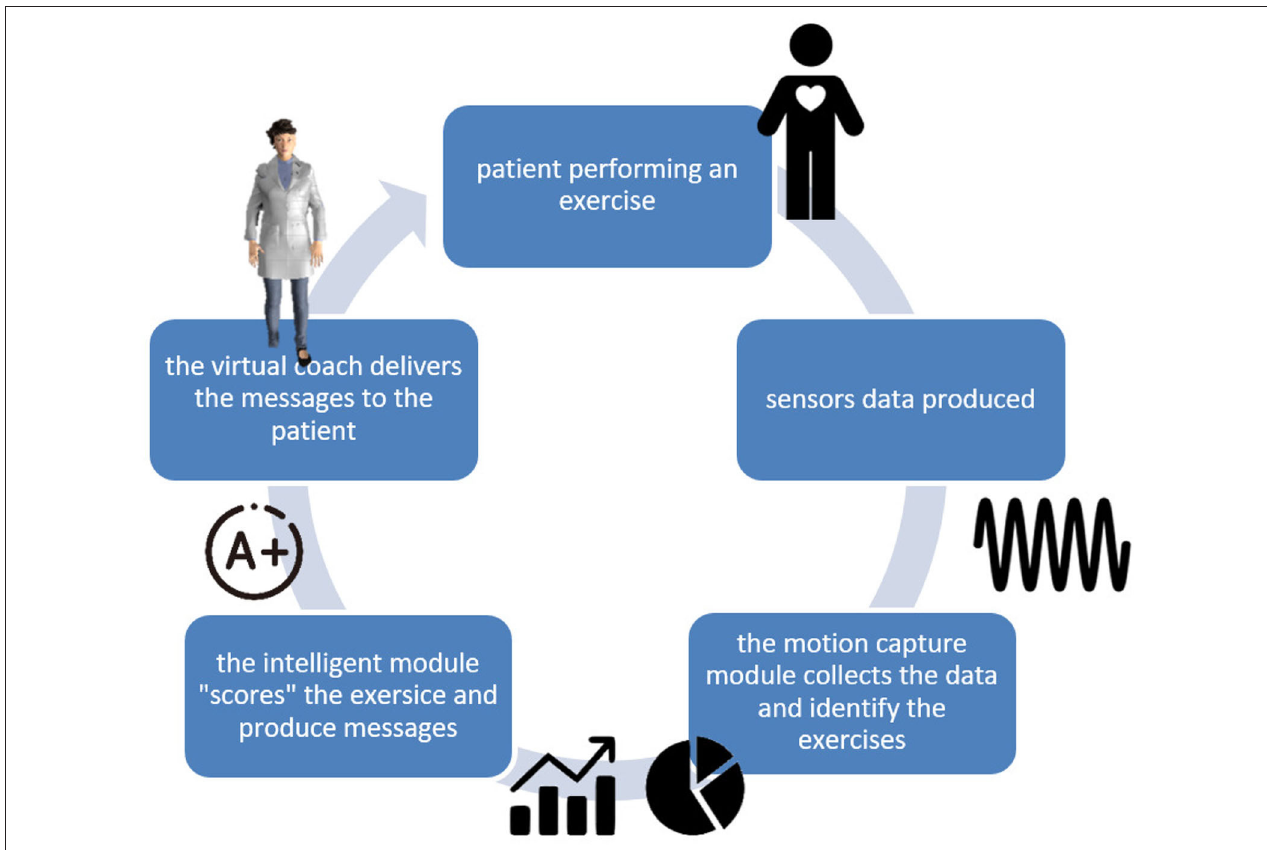
FIGURE 2 | Virtual coaching closed-loop